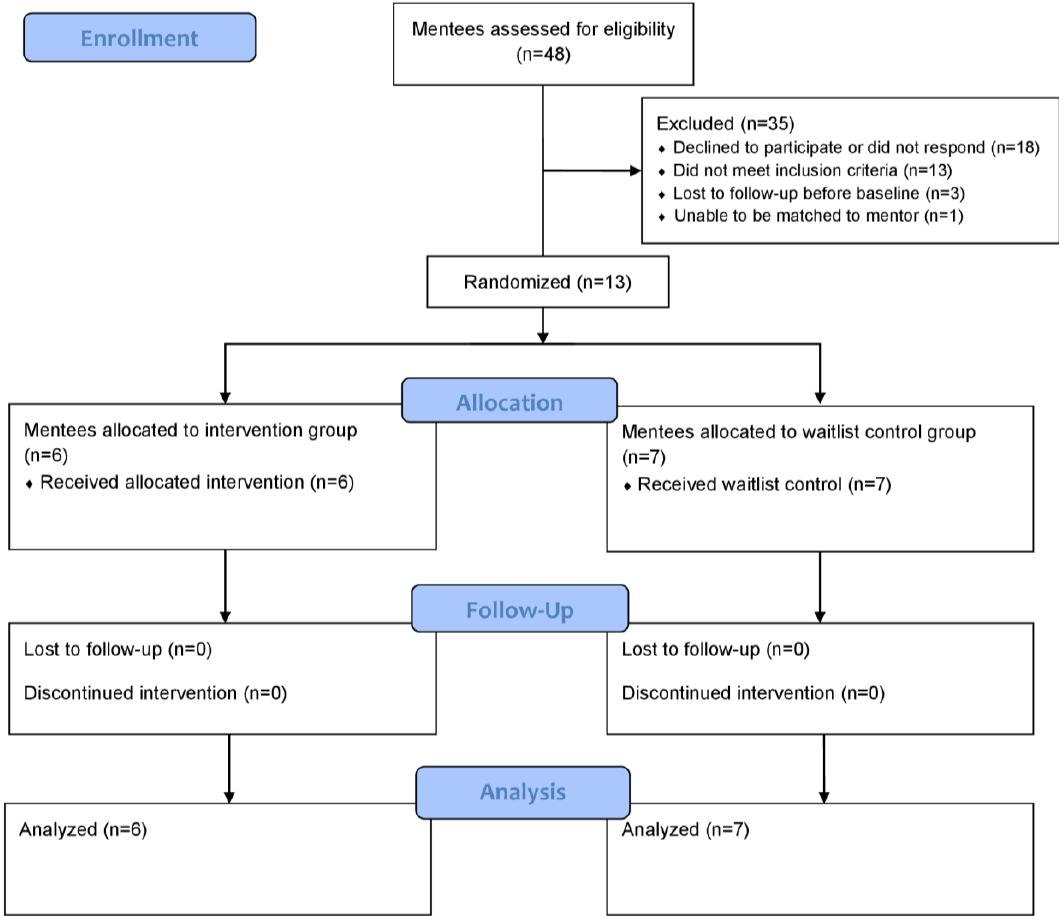
Figure 1. Mentee participant flow diagram. Table 3. Total sessions and average session length for mentee–peer mentor pairs. Mentee–Peer Mentor